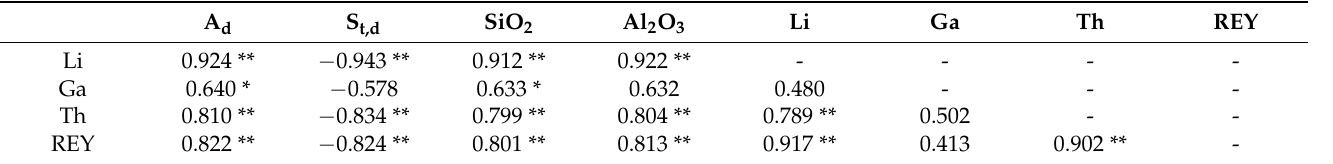
Table 5. Correlations between Li, Ga, Th, REY, ash yield, total sulfur and some major oxides in the No. 9 coal and related roof samples from the Xinyuan